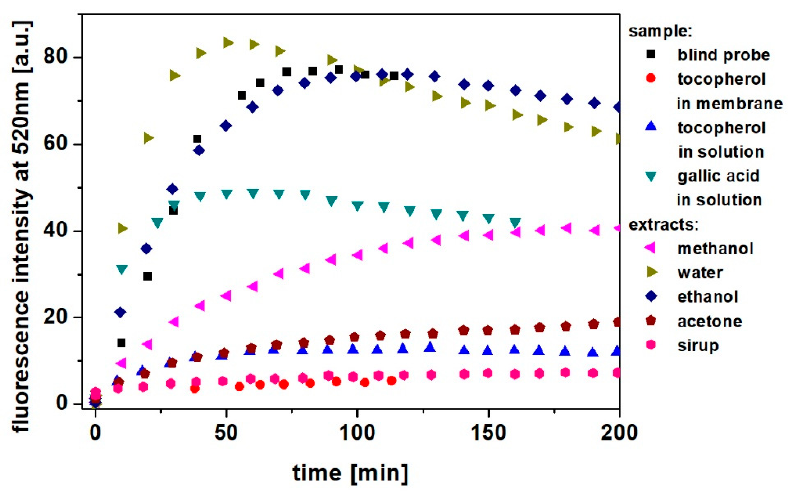
Figure 9. C11-BODIPY581/591 fluorescence changes as a function of time (excitation 505 nm; emission 520 nm).